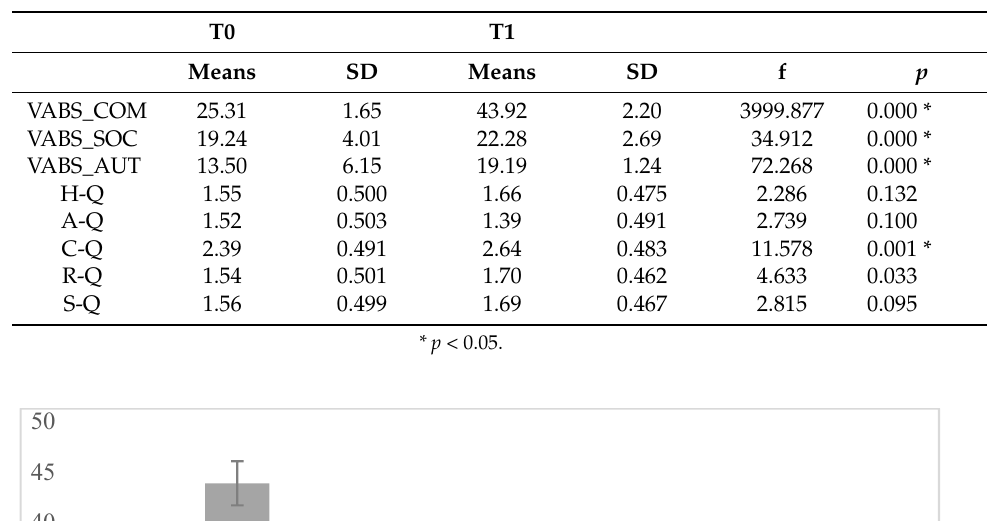
Table 1. Comparisons, T0 and T1.